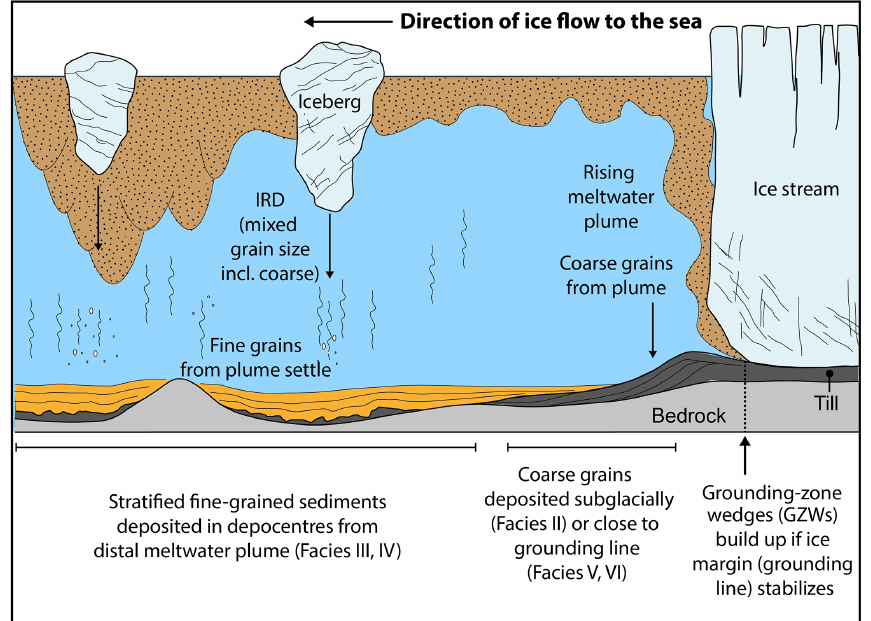
Figure 4. Processes of glacimarine sedimentation at the marine-terminating margin of a Greenland outlet glacier (no ice shelf/tongue). The related seismo-acoustic facies as mapped in the Petermann–Nares Strait system are shown at the bottom of the